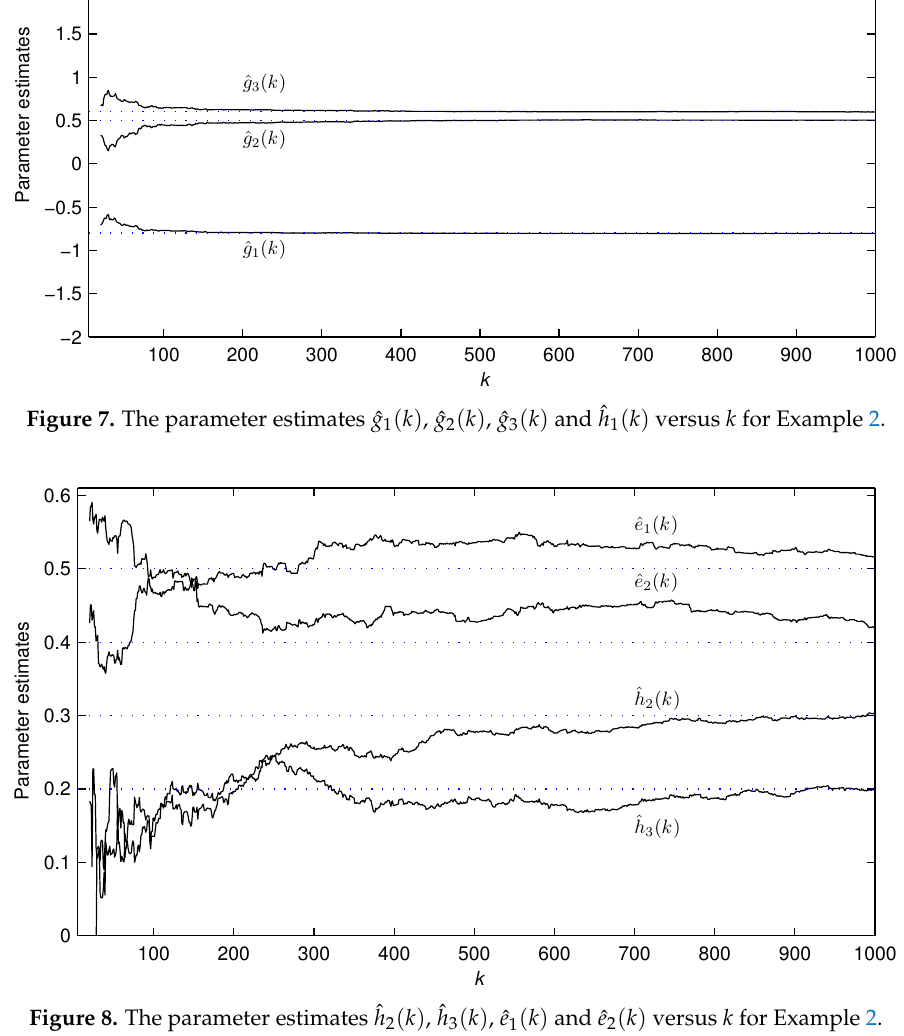
Figure 8. The parameter estimates ˆ h 2 ( k ) , ˆ h 3 ( k ) , ˆ e 1 ( k ) and ˆ e 2 ( k ) versus k for Example